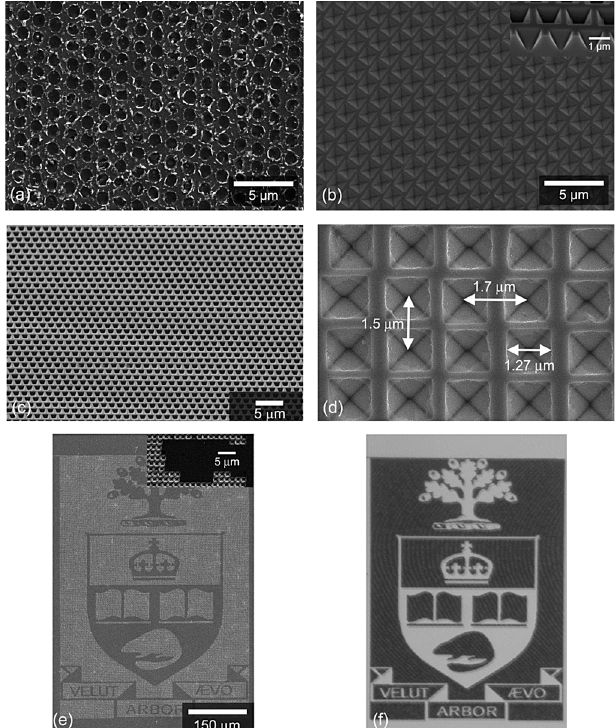
Fig. 3. (a) Top view of a Si wafer with a grid of catapulted blis- ters at 1.5 μ m spacing. KOH etching results in a clean array of 1.3 μ m inverted-pyramids seen in top and cross-sectional views (inset) (b) and in a large area oblique-view (c). The defect-free texture indicates the high reproducibility offered by the de- vised technique. (d) Shows an array of 1.27 μ m sized inverted- pyramids placed at a Λ x = 1 . 5 μ m and Λ y = 1 . 7 μ m. (e) SEM image of a University of Toronto crest micro-patterned with inverted-pyramid structure shown in (e) (inset) demonstrates the capability of the technique to selectively texture areas, leav- ing untextured planar areas for front contacts. The patterned areas appear bright in this image. (f) The optical image of the crest demonstrates the strong anti-reflective effect in the textured